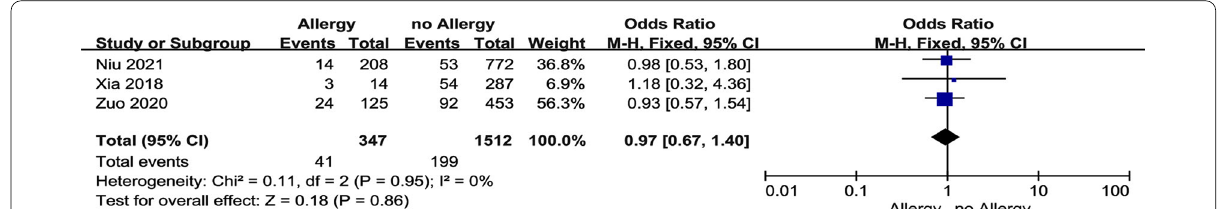
Fig. 9 Forest plot showing a history of allergy in 2 groups. CI confidence interval, df degrees of freedom, M-H Mantel–Haenszel